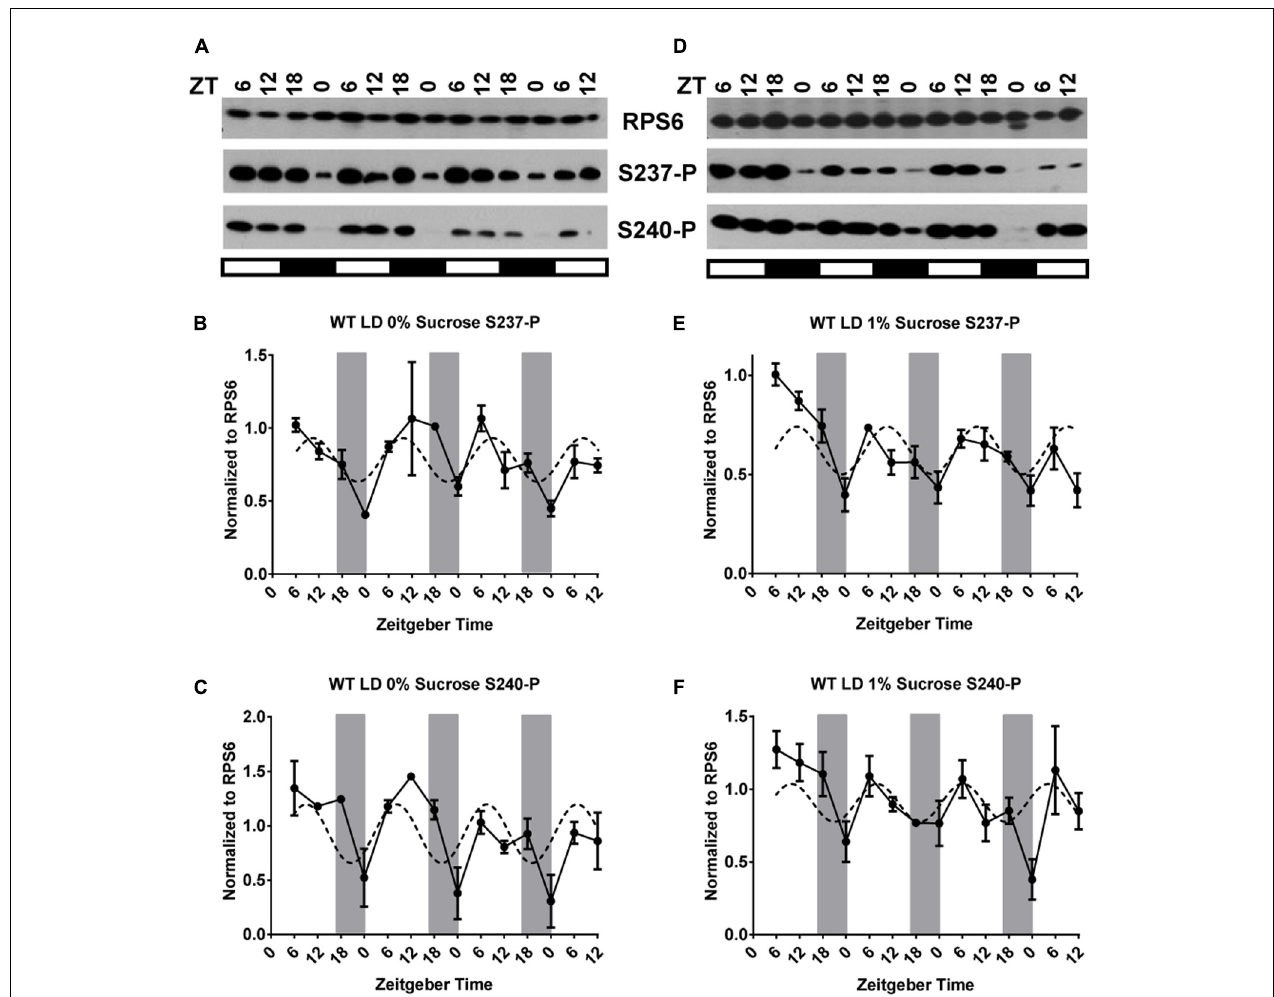
FIGURE 1 | In wild-type seedlings under a light dark cycle, light-driven and clock-driven cycles combine into a low-amplitude cycle with peak phosphorylation during the day. Seedlings of wild-type Arabidopsis were entrained in a light-dark cycle for 12 days, then grown under the same conditions for another three and a half days and scored for phosphorylation of RPS6 (ribosomal protein eS6) every 6 h. Seedlings were grown on medium lacking sucrose (A–C) or containing 1% sucrose (D–F) . Phosphorylation at S237 (S237-P) and at S240 (S240-P) was quantified using phosphospecific antibodies. (A,D) Representative immunoblots for S237-P and S240-P. The total amount of RPS6 was determined with an antibody against an amino-terminal peptide of RPS6. Time is given in hours of zeitgeber time (ZT) after lights-on on Day 12. The white and black bars indicate light and dark conditions, respectively. (B,C,E,F) Immunoblot signals for S237-P and S240-P were quantified using ImageJ software and normalized against total RPS6 signals from the same time point. Each data series was median-centered and data from multiple replicates were averaged. Error bars show the standard error of the mean from n = 2 replicates for 0% sucrose and n = 3 for 1% sucrose, grown at different times, which were immunoblotted once or twice each. A sine curve was fitted to the data as described in Section “Materials and Methods” (dashed line). The dark gray bars indicate the daily dark period.